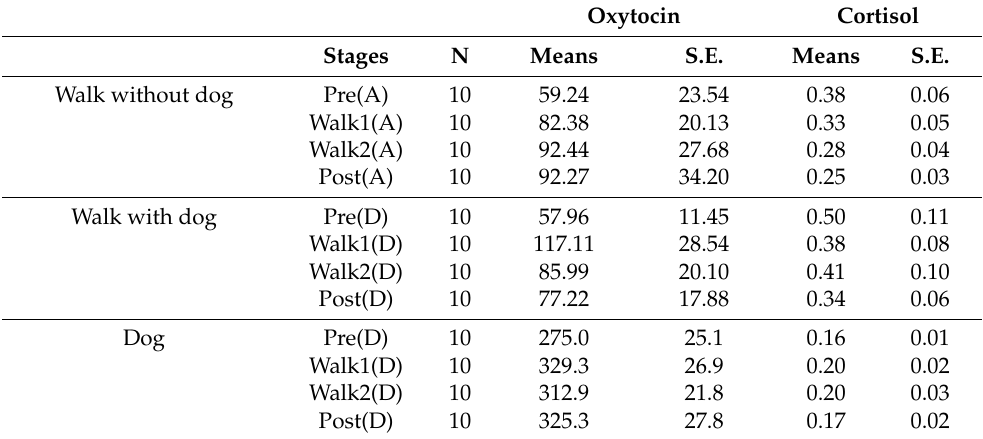
Table 2. The concentrations of oxytocin and cortisol in dog owners and pet dogs in Experiment I.